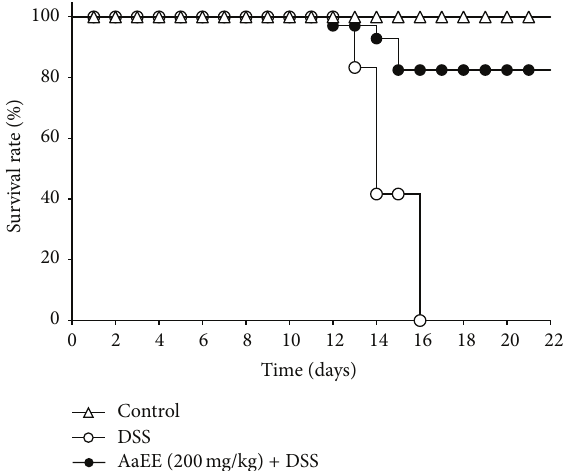
Figure 1: Effect of AaEE on the survival ratio of mice. AaEE prolonged animal survival 𝑃 < 0.001 versus DSS (Mantel-Cox